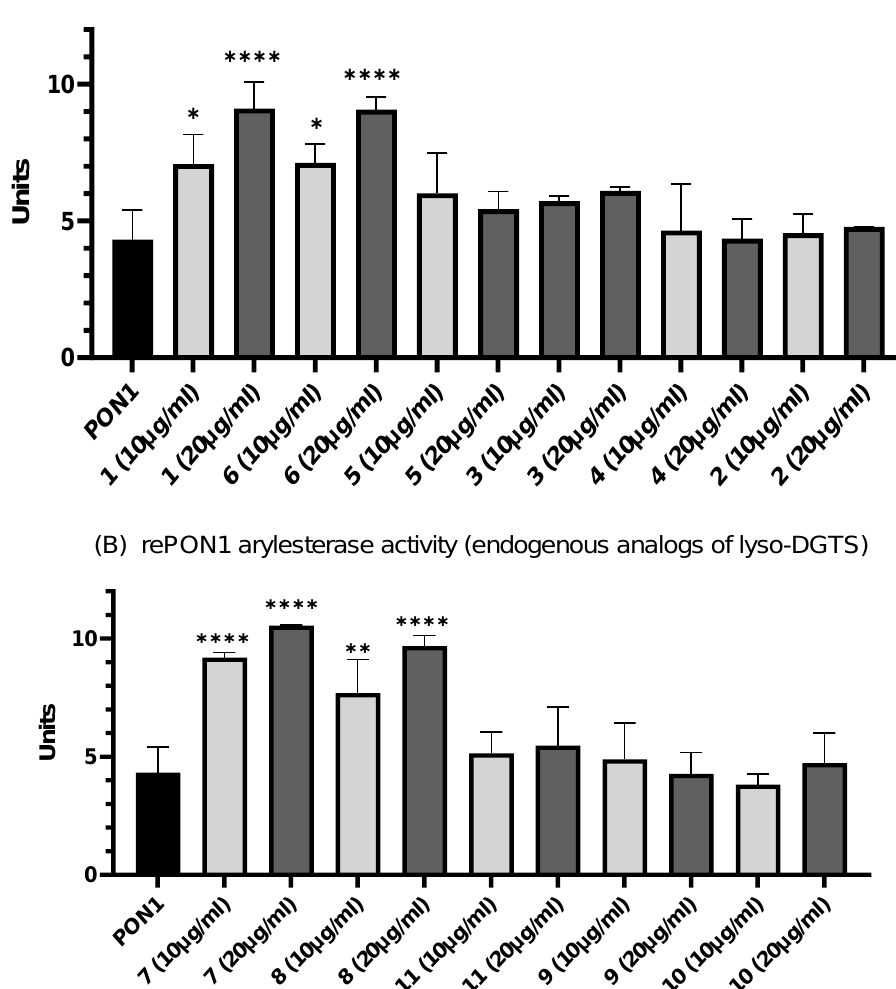
Figure 3. Arylesterase activity of rePON1 after incubation with ( A ) synthesized derivatives of lyso- DGTS and ( B ) endogenous analogs of lyso-DGTS. rePON1 (5 µg/mL) was incubated with the lipid at concentrations of 10 and 20 µg/mL for 2 h at 37 °C in Tris buffer pH 8.4. Then, arylesterase activity of rePON1 was measured via phenylacetate assay and the results were expressed as units defined by the ability of rePON1 to hydrolyze 1 mM phenylacetate in 1 min. Each experiment was repeated separately at least three times. * p ≤ 0.05, ** p ≤ 0.01, **** p ≤ 0.0001 relative to the control (PON1; rePON1 without bioactive lipid). Statistical analysis was via one-way ANOVA and Graphpad prism 9 software. See Figure 1 for compounds corresponding to each